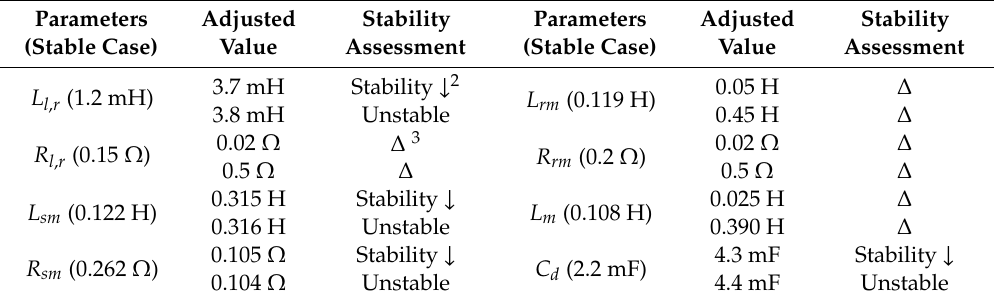
Figure 16. The Nyquist plots of the feedback loop gain: ( a ) Nyquist plots in the stable case ( L l = 3.7 mH), the graphs on the right are the magnified parts in ( − 1, j0). The curve does not encircle the point ( − 1, j0), which predicts the system is still stable; ( b ) Nyquist plots in the unstable case ( L l = 3.8 mH), the graphs on the right are the magnified parts in ( − 1, j0). The curves finally enclose the point ( − 1, j0) and the system becomes unstable. Table 3. Circuit parameter influences and assessments on the system’s stability 1 .